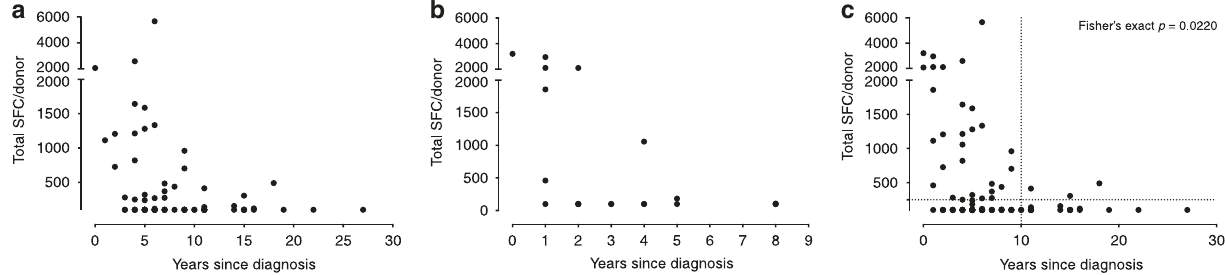
Fig. 3 Correlation between T cell reactivity and time since diagnosis. a Cohort 1 ( n = 76 PD patients from UCSD, RUMC, LJI, and UAB), b Cohort 2 ( n = 20 PD patients from UAB), c Cohorts 1 and 2 combined ( n = 96 PD patients). The Y -axis shows the magnitude of responses (sum of IFN γ , IL-5, and IL-10) against the α -syn peptide pool as SFC per 10 6 cultured PBMC. The X -axis shows the years since PD diagnosis. Each point represents one donor. Because many participants showed no response, there are overlapping points at the limit of detection (100 SFC). Two-tailed Fisher ’ s exact test.